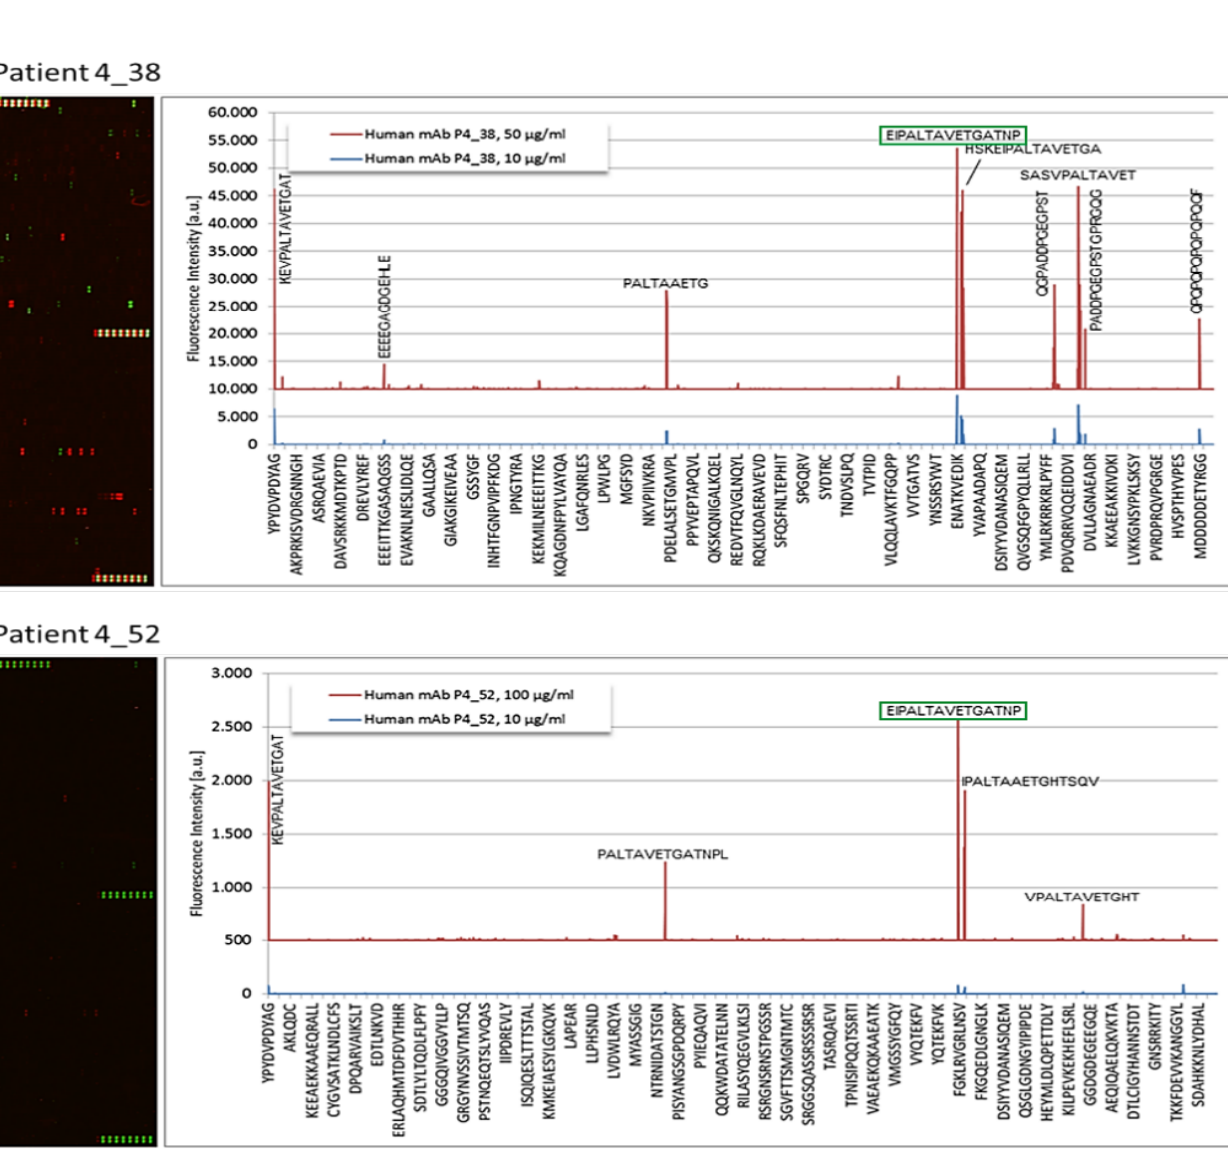
Figure 1. Results of PEPperCHIP ® Infectious Epitope MicroArrays obtained for Monoclonal IgGs Specific for VP1 Coat Protein of Human Polioviruses.Microarrays were incubated with the patient monoclonal IgG (50 or 100 µ g/mL), stained with secondary and control antibodies, then read out at scanning intensities of 7/7 (red/ green) (see Materials and Methods). Antibody response against peptides is annotated next to corresponding signals in the intensity plot (left panel). Well-defined staining of HA control peptides appear in green; PV control peptides appear in red. Table 1. PEPperCHIP ® Infectious Epitope MicroArray Results of monoclonal gammopathy of un- determined significance (MGUS)/ smoldering myeloma (SM) Monoclonal IgGs.